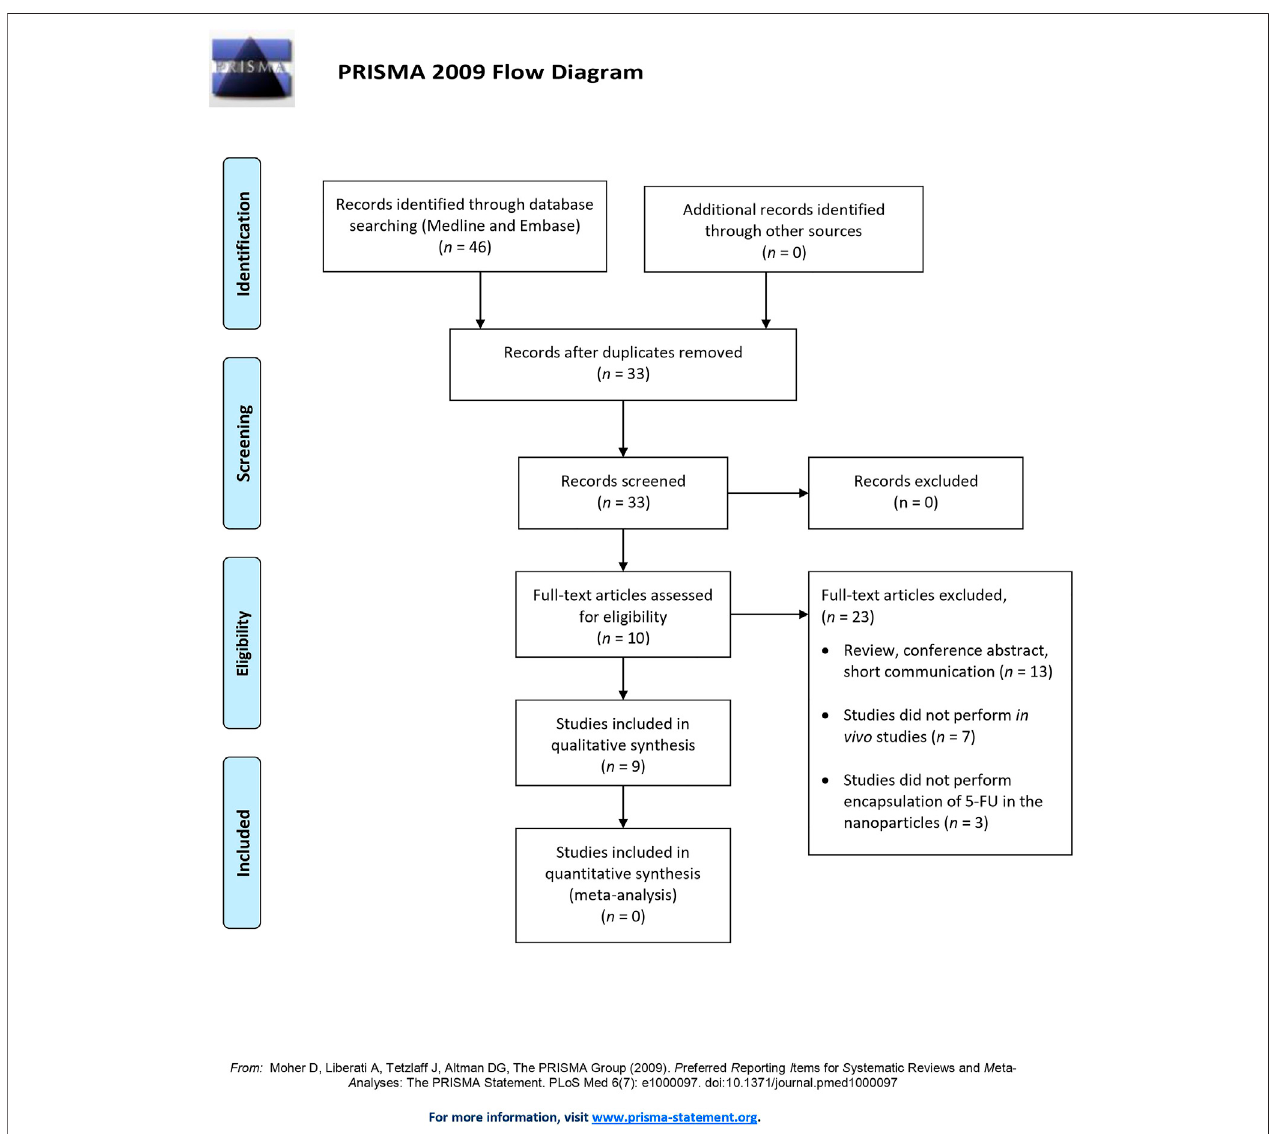
FIGURE 1 | The Preferred Reporting Items for Systematic Reviews and Meta-Analysis (PRISMA) fl ow diagram of study selection.